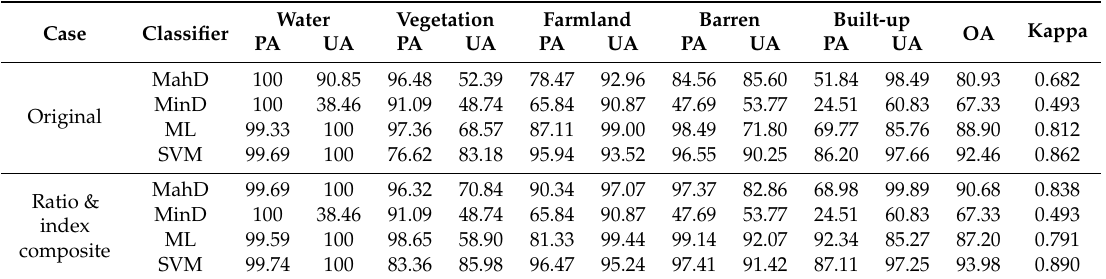
Table 3. Accuracy measures of Mahalanobis Distance (MahD), Minimum Distance (MinD), Maximum Likelihood (ML) and Support Vector Machine (SVM) classifiers in the study